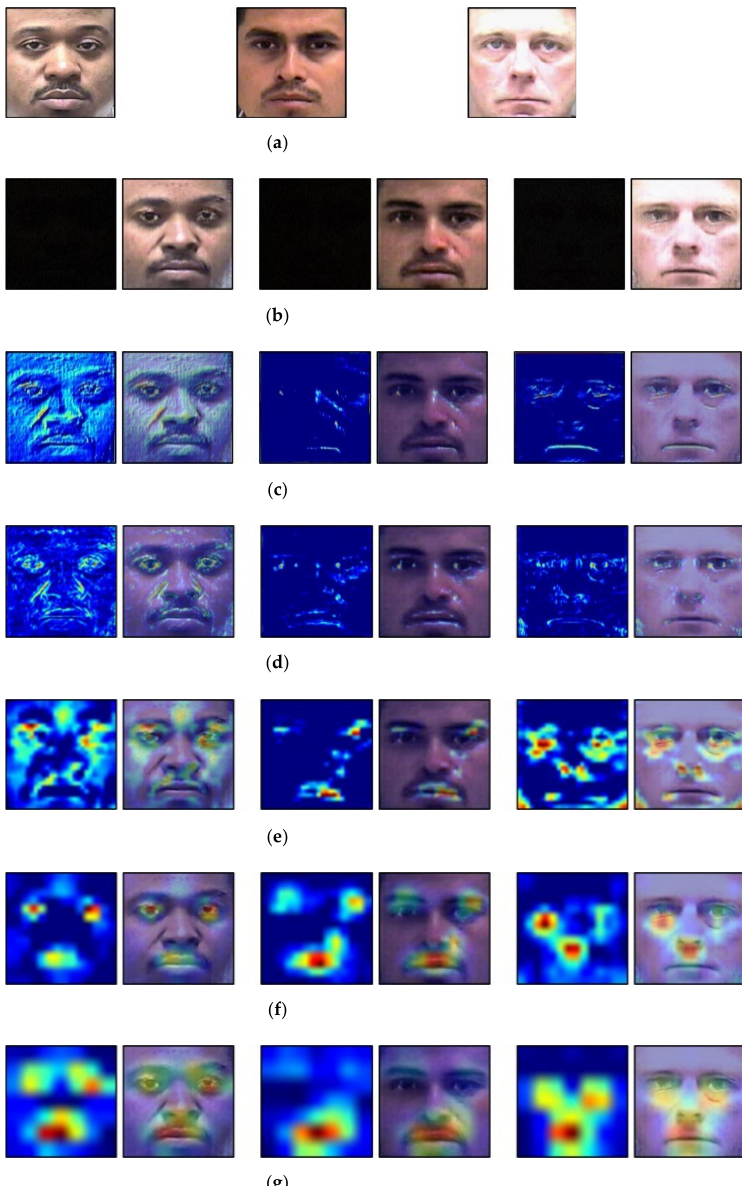
Figure 16. Examples of Grad-CAM images extracted from DEX where LAE-GAN enhanced images are used as input. ( a ) Original images, ( b ) low-illumination images (left) and LAE-GAN enhanced images (right). ( c – g ) are Grad-CAM images extracted from the first, fourth, eighth, and eleventh convolutional layers and the last max pooling layers of DEX. The left pictures in Figure 16c–g are Grad-CAM images, while the right pictures are the LAE-GAN-enhanced images overlapped with the Grad-CAM images. As shown in Figure 16c,d, high activation areas, mostly in the high frequency areas such as the eyes, nose, mouth, and lines, in the Grad-CAM images are extracted from the